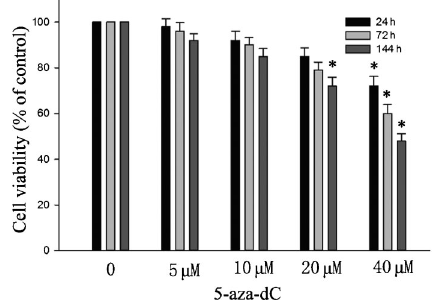
Figure 1. Effect of 5-aza-2 9 deoxycytidine (5-aza-dC) on viability of ACC-M cells. Cells were treated with various concentrations of 5-aza-dC for 24, 72, and 144 h. Cell viability is reported as means±SD of 3 independent experiments. *P , 0.05 compared with control (ANOVA).